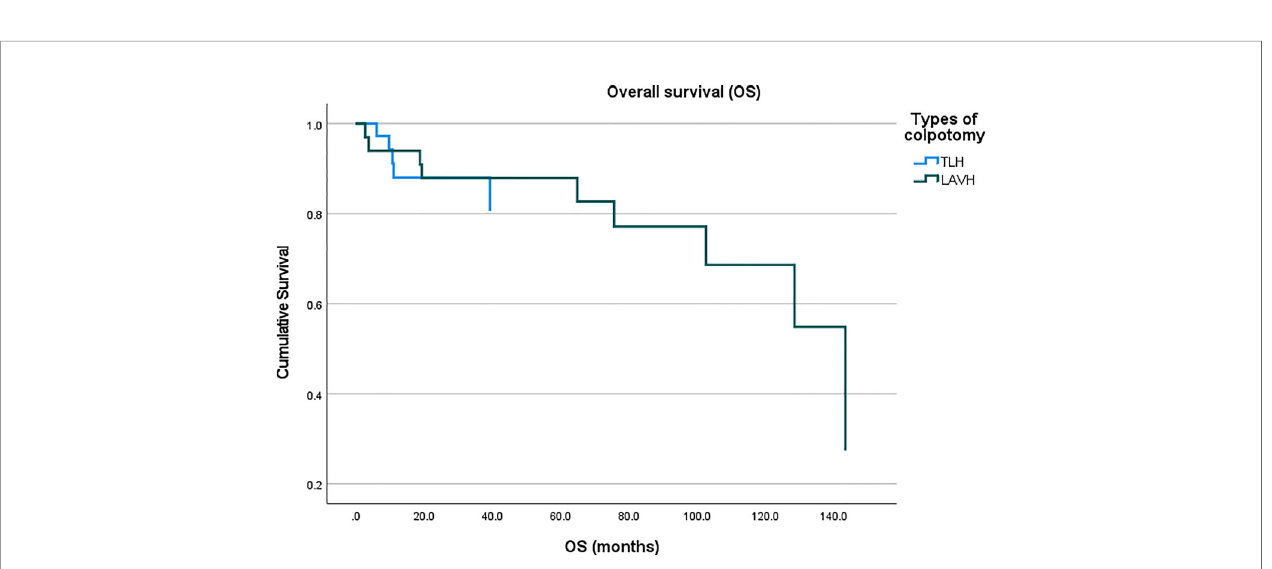
FIGURE 5 | Comparison of overall survival of the patients with endometrial cancer who underwent intracorporeal colpotomy (TLH, total laparoscopic hysterectomy) vs . transvaginal colpotomy (LAVH, laparoscopy-assisted vaginal